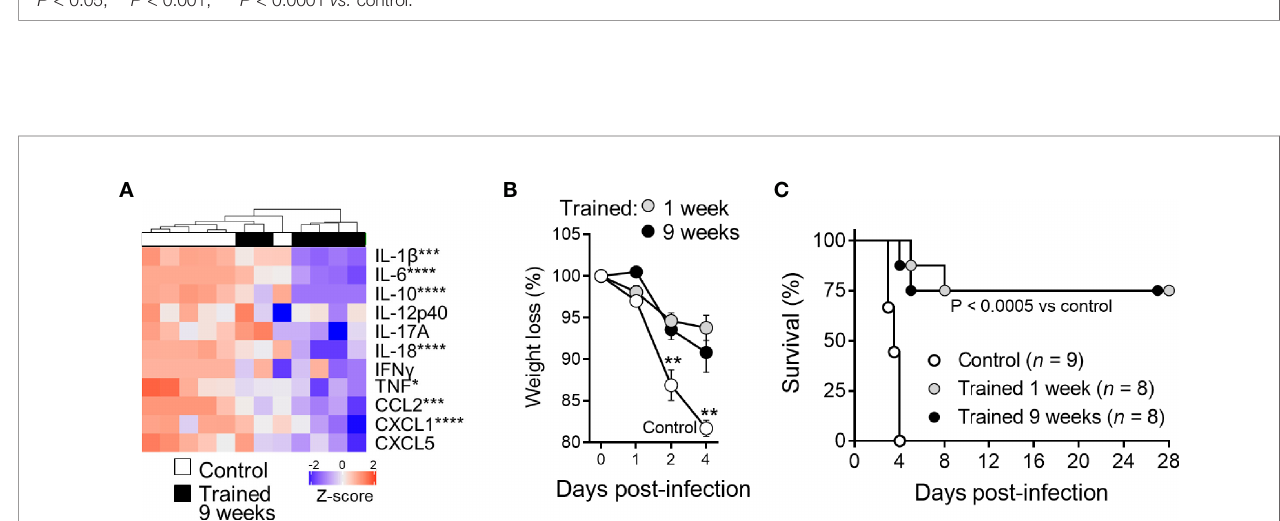
FIGURE 8 | Training for 9 weeks increases mice survival from lethal listeriosis. Control mice and mice trained 1 week and 9 weeks before infection were challenged i.v. with 1.7 x 10 4 CFU L. monocytogenes . (A) Blood was collected 2 days after infection to quantify cytokines (IL-1 b , IL-6, IL-10, IL-12p40, IL-17A, IL-18, IFN g , TNF, CCL2, CXCL1, and CXCL5). Heatmap and hierarchical clustering of cytokine levels was performed using Z-score normalization. (B, C) Weight loss (expressed in percentage of initial weight) and survival of mice. Data are means ± SD (B) . * P < 0.05; ** P < 0.01; *** P < 0.001; **** P < 0.0001 vs.